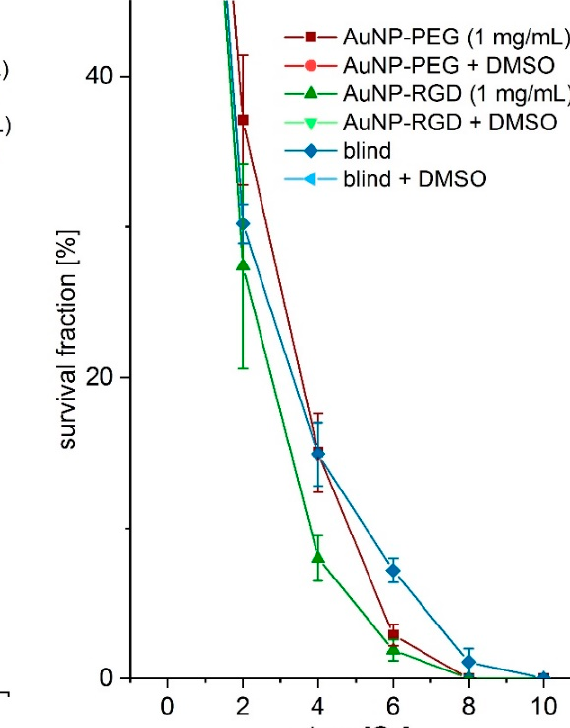
Figure A21. Toxicology assay for AuNP-PEG 1 with survival fraction 10–100% logarithmic scale ( left ) and 80–110% linear scale ( right ).